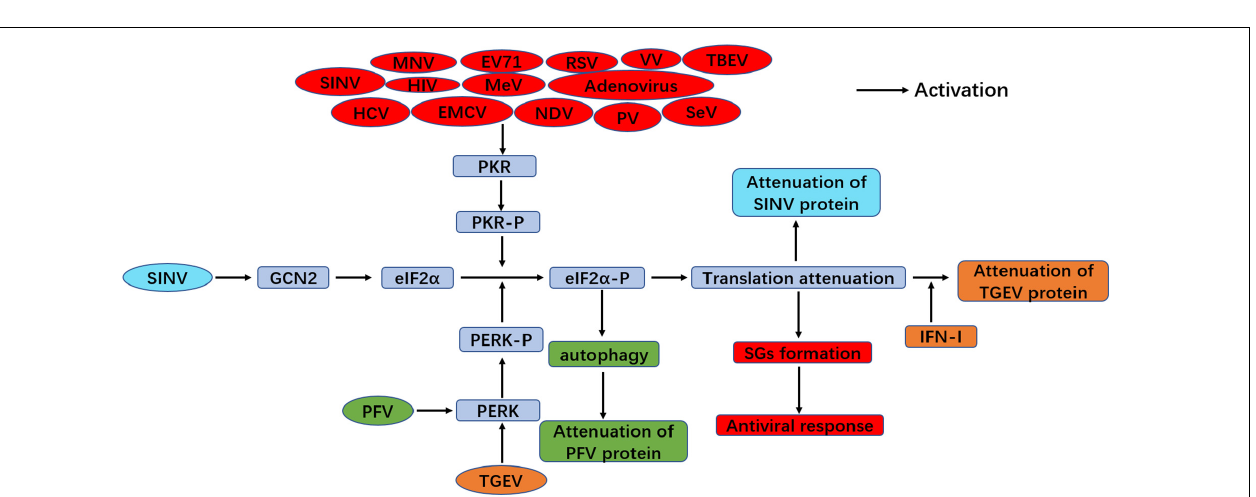
FIGURE 3 | Diagram of SGs formation under viral infection. SGs formation: EV71, VV, HIV, HCV, SeV, EMCV, RSV, TBEV, MeV, TMEV, Adenovirus, NDV, and SINV infection induce SGs formation through the PKR-eIF2 α -P signaling pathway. MeV, Reovirus, SFV, rotavirus (RV), HSV, VSV, MHV, and MRV benefit SGs formation via direct eIF2 α phosphorylation (blue color). However, MNV, nervous necrosis virus (NNV) infection, and the expression of IAV-NS1, FMDV-L pro , PV-3C pro , TMEMV-L pro , and EMCV-3C inhibit SGs formation through blocking eIF2 α phosphorylation (red color). SGs formation is increased via the PERK-eIF2 α -P signaling during human cytomegalovirus (HCMV) infection. SINV infection enhances SGs formation through the GCN2-eIF2 α -P signaling pathway.